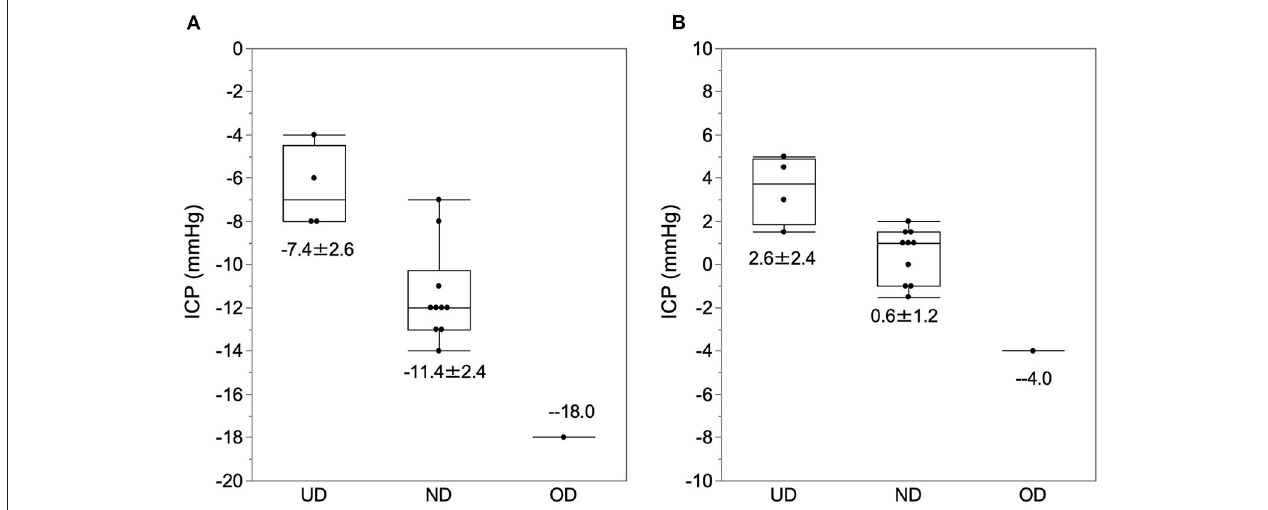
FIGURE 5 | The ICP at the time of normal drainage, underdrainage, and overdrainage. The ICP data at the time of normal drainage, underdrainage, and overdrainage and their boxplots are plotted in the sitting (A) and supine (B) positions. (A) In the sitting position, the ICP for underdrainage, normal drainage, and overdrainage were − 7.4 ± 2.6, − 11.4 ± 2.4, and − 18.0mm Hg, respectively. (B) In the supine position, ICP levels for underdrainage, normal drainage, and overdrainage are 2.6 ± 2.4, 0.6 ± 1.2, and − 4mm Hg, respectively. The cutoff values of ICP for underdrainage and normaldrainage in the sitting and supine positions were − 8.0 and 2.0mm Hg, respectively. ND, normal drainage; UD, underdrainage; OD,